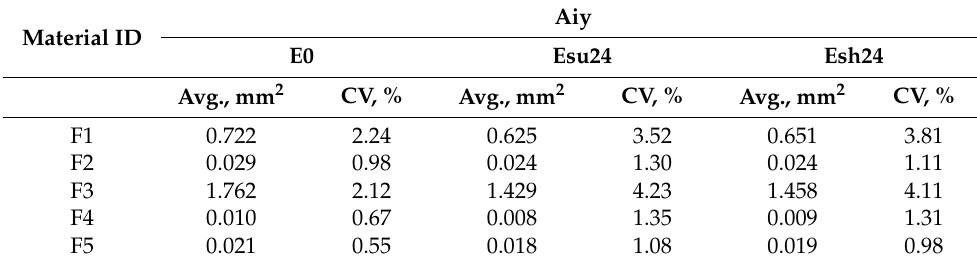
Table 3. The average values of the intra yarn area (Aiy).